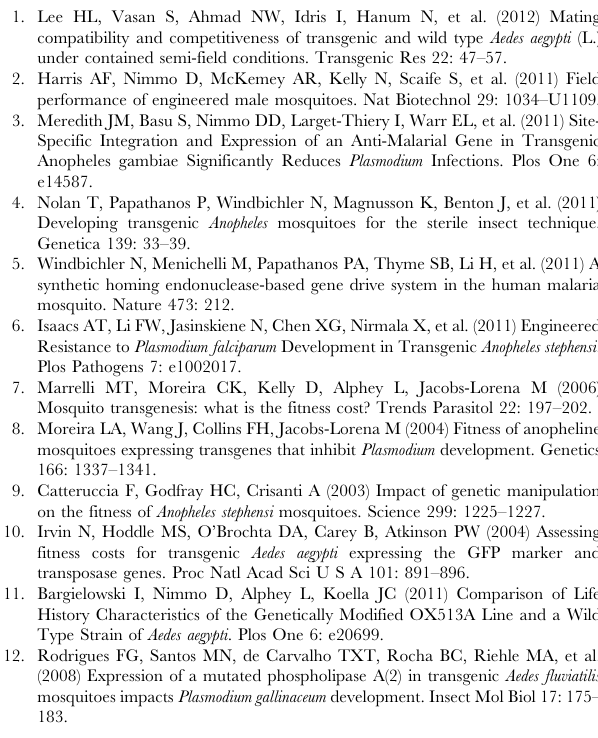
Table S1 Genotypic frequency over time, EE vs Mopti comparison. The frequency of individuals homozygous and hemizygous for the Phase-1 EE construct and homozygous wild- type individuals over 10 generations in three replicates. Table S2 Genotypic frequency over time, EVida3 vs Mopti comparison. The frequency of individuals homozygous and hemizygous for the Phase-2 EVida3 construct and homozy- gous wild-type individuals over 10 generations in three